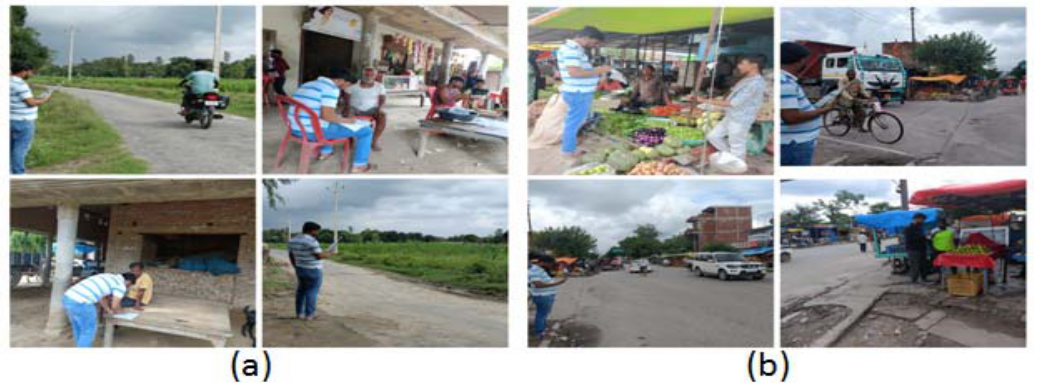
Figure 4. Study area location at Bahadurpur.